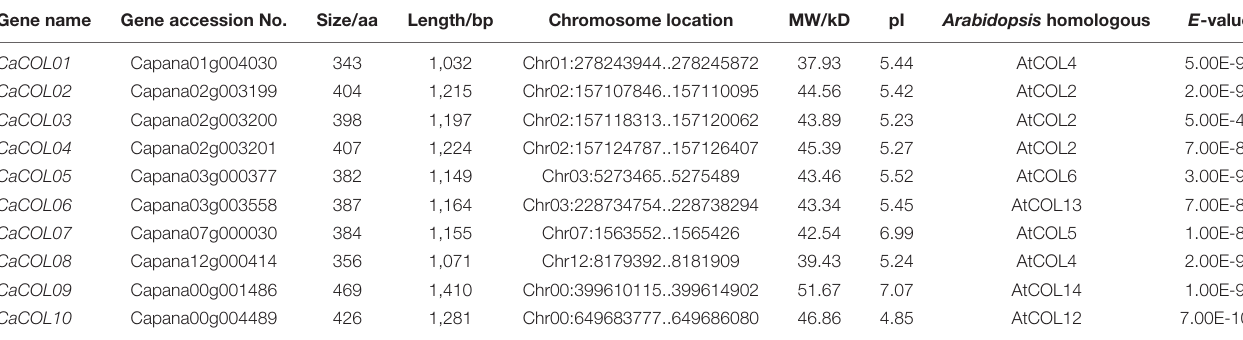
TABLE 1 | The information of COL gene family in pepper Zunla-1